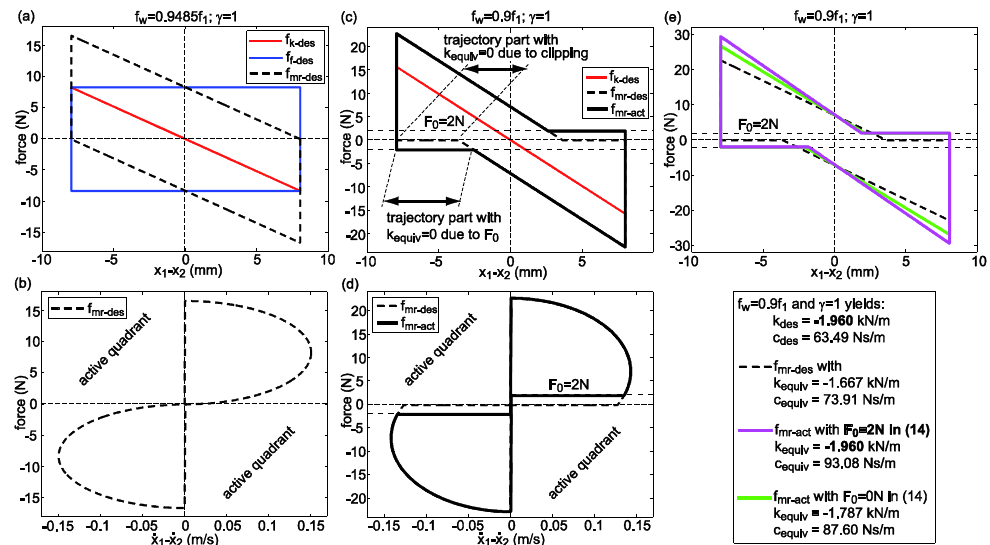
X/F|k|  and further ddesdes | k | > F des des / X d and further constrained